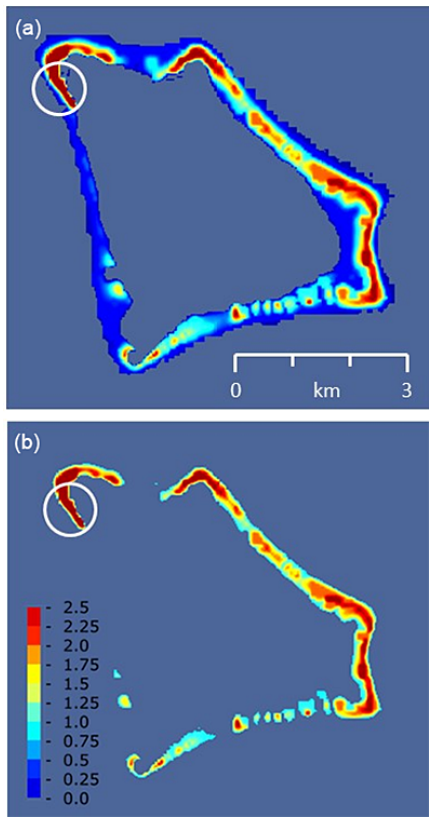
Figure 3. Example of the model-generated topography for Atafu, the smallest and northernmost atoll of the Tokelau group. The land topography is in metres above mean sea level (m.s.l.) (a) , and at Mean High Water Spring (MHWS) (b) , at a regular spatial reso- lution of 15m. In the time-dependent tsunami runs, the adaptive grid in Gerris will evolve and select the appropriate grid dimensions consistent with the tsunami wave as it approaches and subsequently passes the islands. The vertical land heights span a relatively limited range of 0.25–5m. In contrast the surrounding ocean ranges from around zero at the reef edge to thousands of metres’ water depth within a short distance seaward of the shoreline. The lagoons have inferred depth ranges spanning many tens of metres (no verified measured depths were available). The village of Atafu is indicated by the circle in the northwestern corner of the